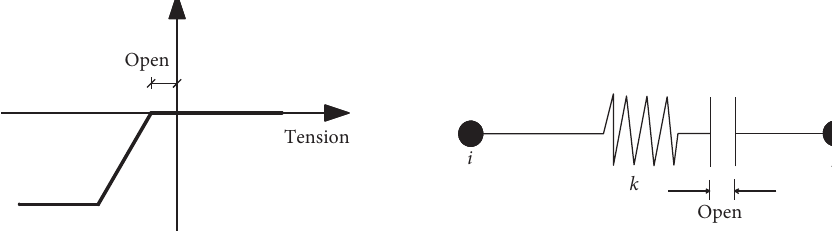
Figure 7: Constitutive relation and axial deformation of the GAP element.